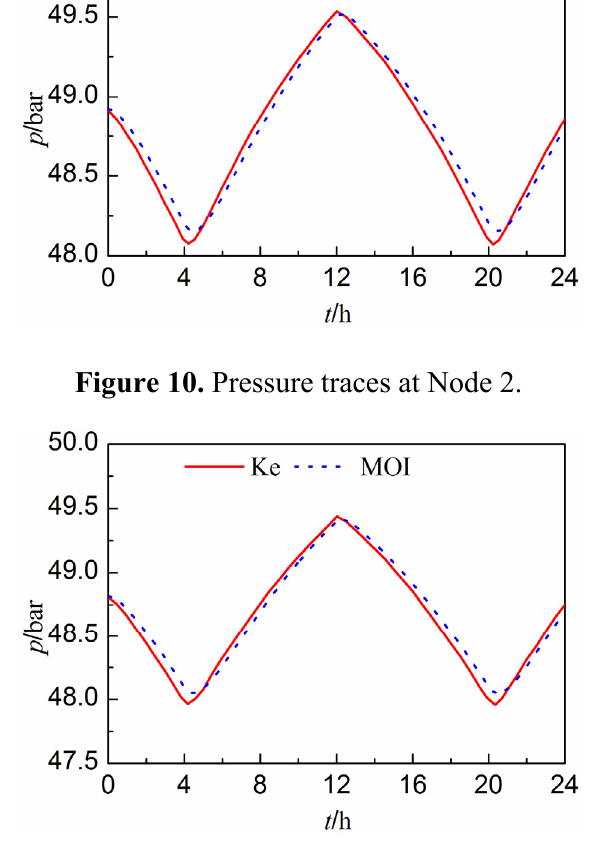
Figure11. Pressure traces at Node